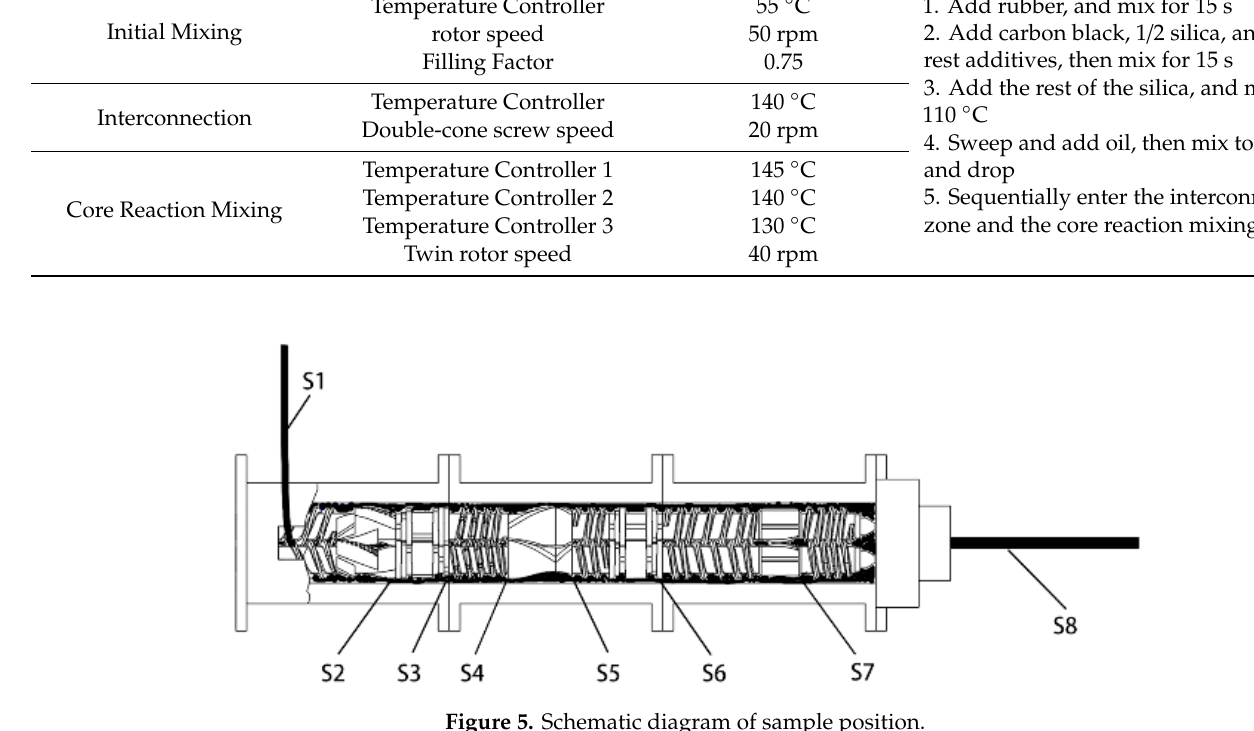
Table 3. Serial continuous mixing process.